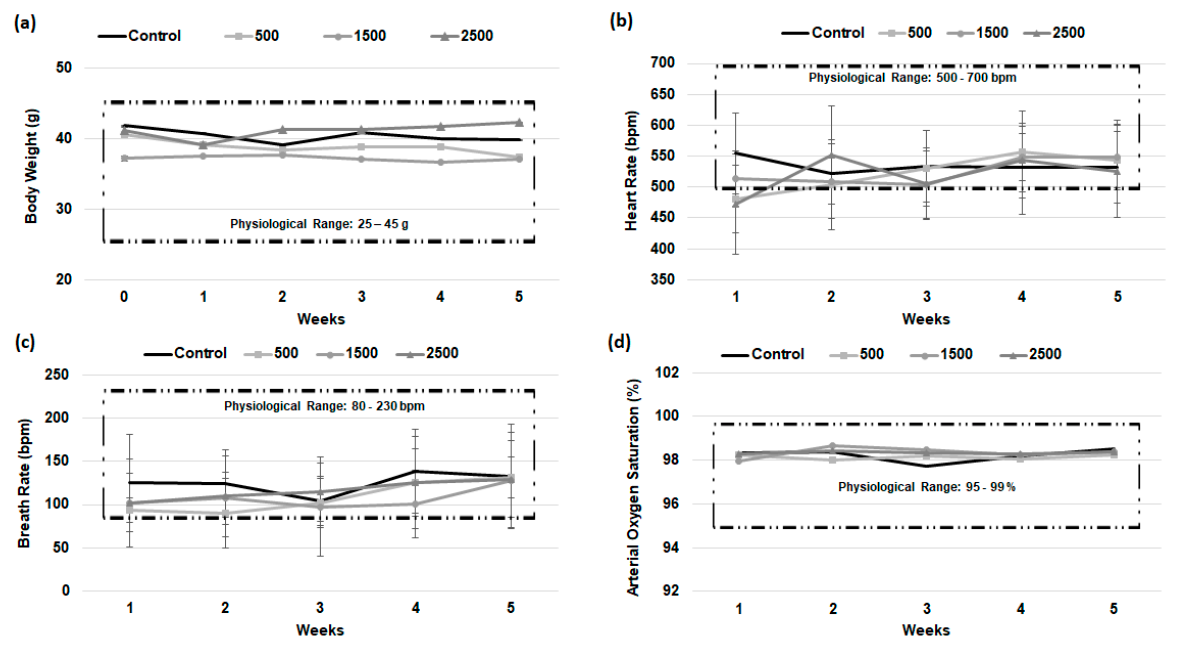
Figure 2. Effect on mouse body weight ( a ) and vital signs ( b – d ) after oral administration of the test compound at various doses. All values were within the physiological range and comparable to that of the control group. No statistically significant differences were observed between the two genders. Results are shown as mean ± SD.